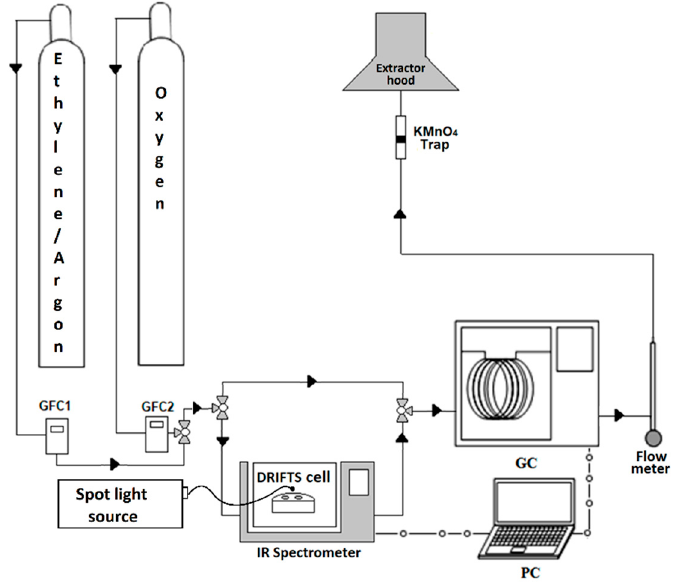
Figure 10. Schematic representation of the experimental set-up used for photocatalytic oxidation of ethylene.